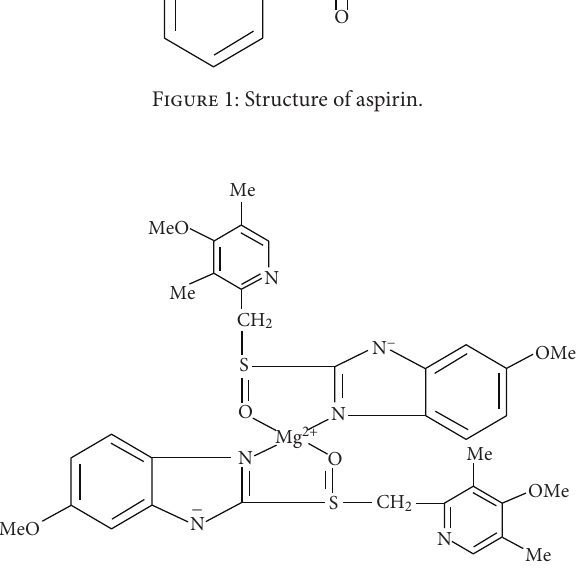
F 2: Structure of esomeprazole magnesium.